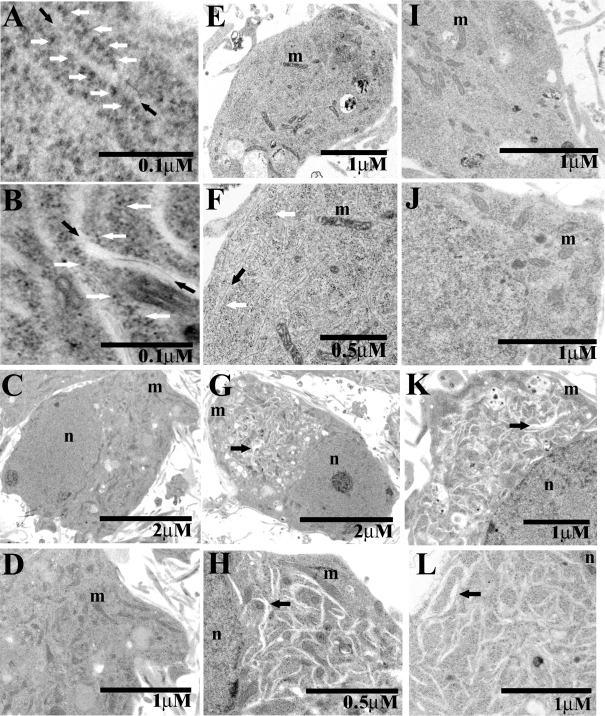
HIV-1 Tat induces endoplasmic reticulum neuropathologic changes in cortical neurons.A–L, The following symbols are used throughout the montage: m, mitochondria; n, nucleus; black arrows, ER; white arrows, ribosomes. A, Control neurons displayed classic rough ER morphology with ribosomes contiguous with the rough ER membrane. B, Cortical neurons treated with 8 nM Tat demonstrated a dilation of ER and a dissociation of ribosomes. C, An untreated cortical neuron displayed normal morphology. D, A magnified image of the untreated cortical neuron in C. E, Cortical neuron treated with 8 nM Tat for 15 minutes. F, A magnified image of the treated [8 nM Tat] cortical neuron. G, Cortical neuron treated with [8 nM] Tat for 15 minutes displayed dilated ER. H, Magnified image of treated neuron in G. The dilated ER at this level of magnification was highly prominent. I, Cortical neurons pretreated with an antagonist concentration [20 µM] of ryanodine for 30 min before [8 nM] of Tat treatment displayed none of the pathology demonstrated in previous images. J, Cortical neurons pretreated with the RyR antagonist [25 µM] dantrolene for 30 min before [8 nM] of Tat treatment had similar morphologies to those that received [20 µM] ryanodine pretreatment. K, Cortical neurons pretreated with the IP3 inhibitor [100 µM] TMB-8 for 1 hour before Tat [8 nM] treatment failed to attenuate the morphological pathology induced by Tat. L, Cortical neurons pretreated for 30 minutes with 2 µM MK-801 also failed to attenuate the pathology elicited by treatment of Tat [8 nM].